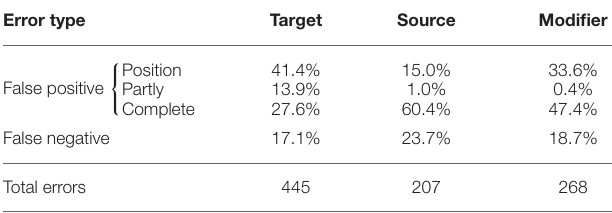
TABLE 4 | Distribution of error types of BERT-SEQ in all